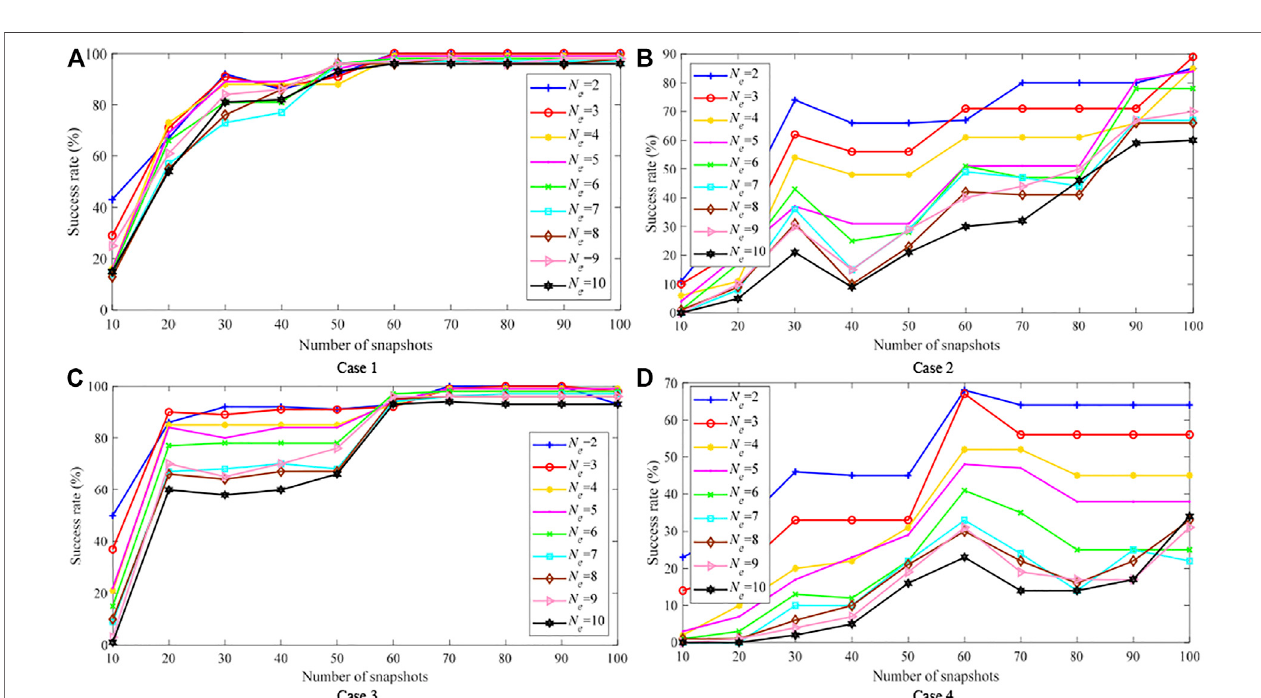
FIGURE 9 | PEI success rate of the IEEE 118-bus